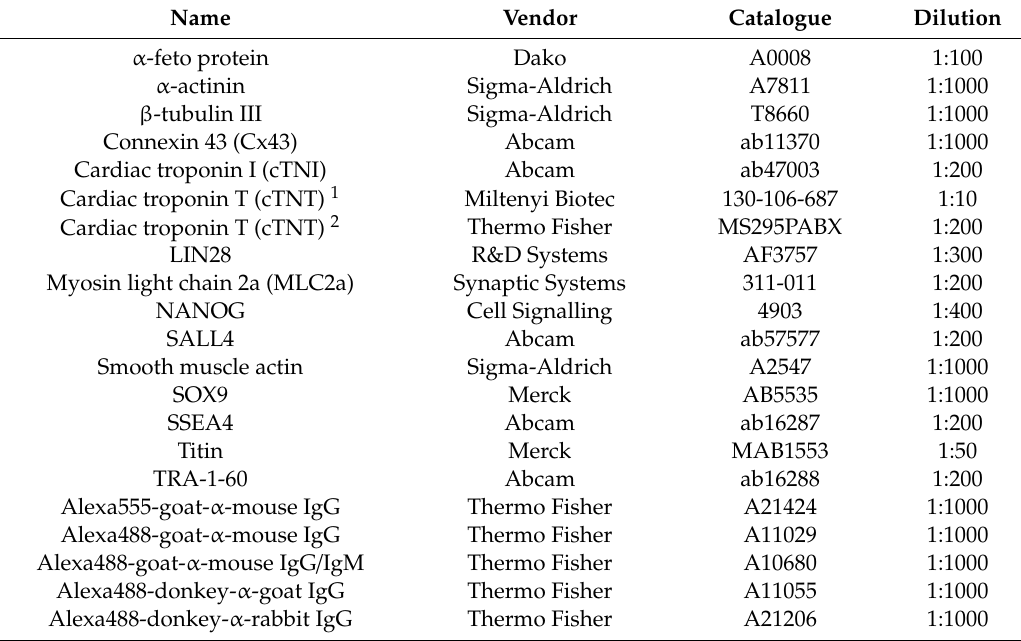
Table 1. Primary and secondary antibodies used in this